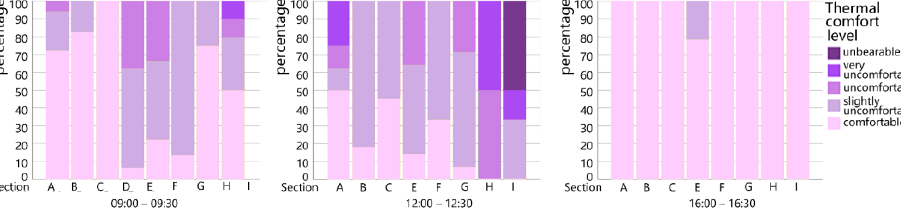
Figure A12. Thermal comfort votes of the three time periods on 12 September.